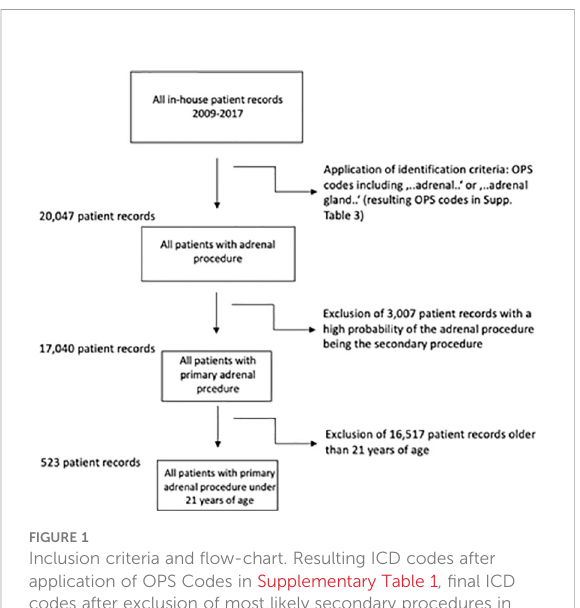
FIGURE 1 Inclusion criteria and fl ow-chart. Resulting ICD codes after application of OPS Codes in Supplementary Table 1, fi nal ICD codes after exclusion of most likely secondary procedures in Supplementary Table